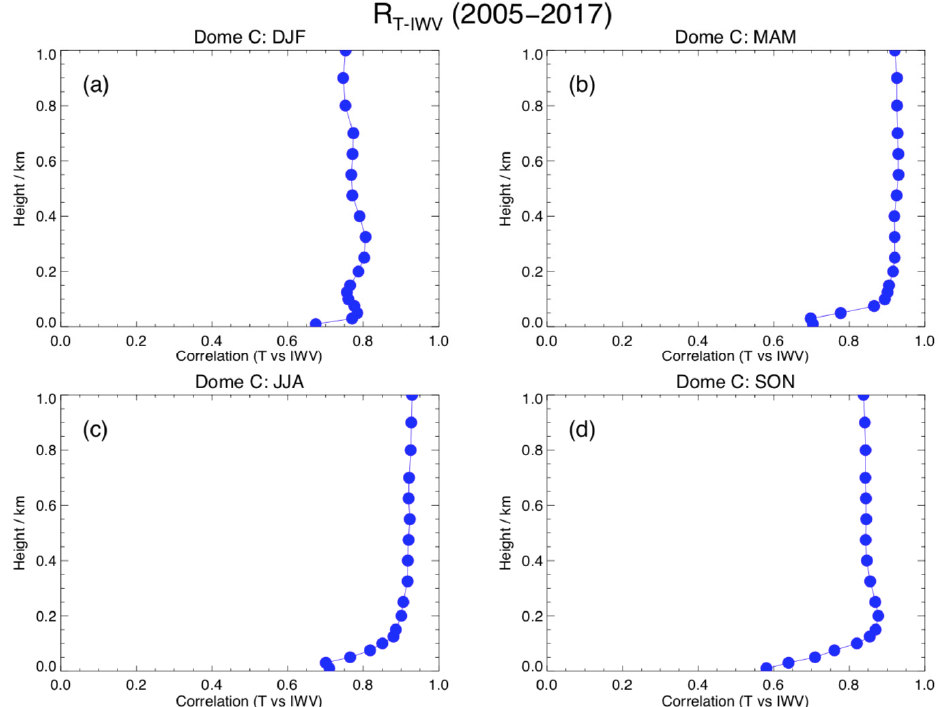
Figure 3. Vertical profile of the linear Pearson correlation coefficient R T-IWV between IWV and temperature (T) from radiosondes at Dome C, over the period 2005–2017 in ( a ) DJF; ( b ) MAM; ( c ) JJA; and ( d ) SON.